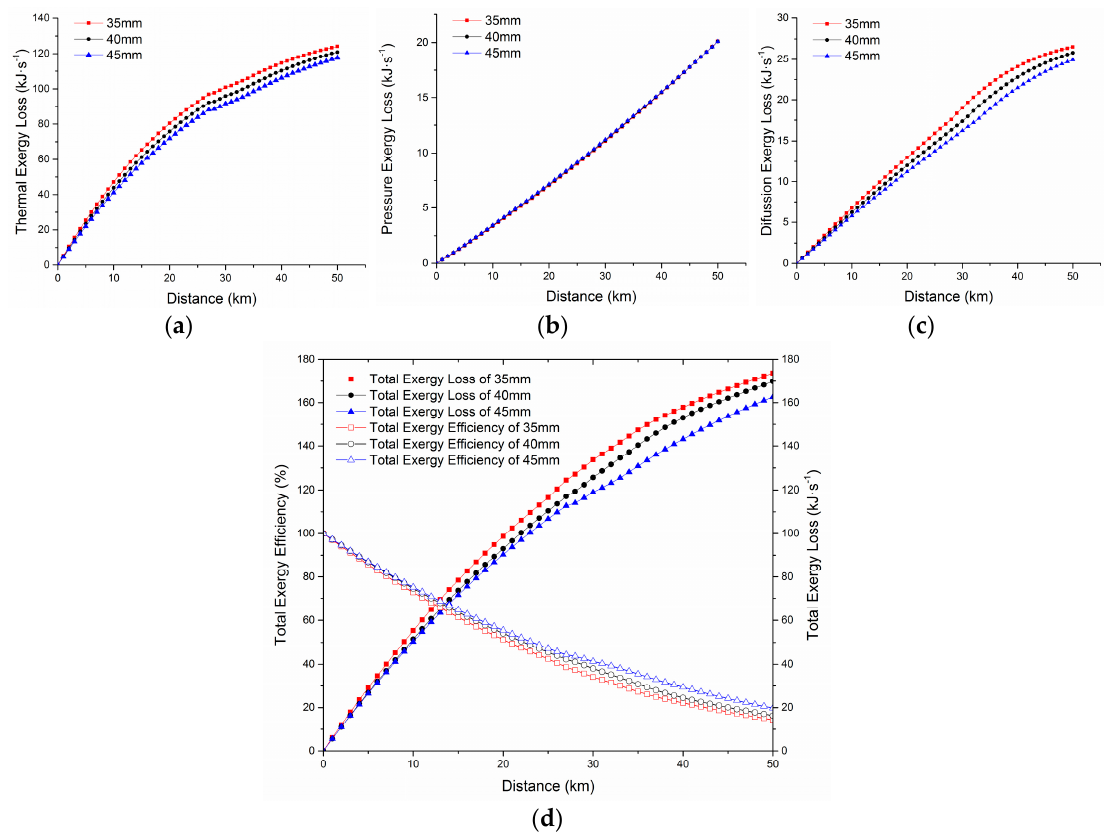
Figure 7. ( a ) The axial distribution of thermal exergy loss under different insulation thicknesses; ( b ) The axial distribution of pressure exergy loss under different insulation thicknesses; ( c ) The axial distribution of diffusion exergy loss under different insulation thicknesses; ( d ) The axial distribution of total exergy loss/efficiency under different insulation thicknesses.